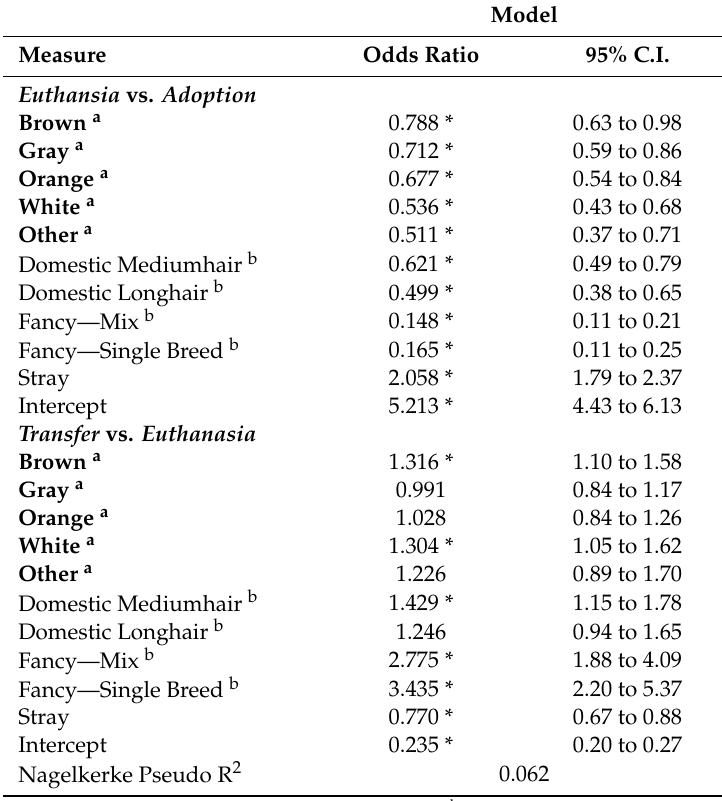
Table 2. Multinomial Logistic Regression of Cat Outcome on Coat Color and